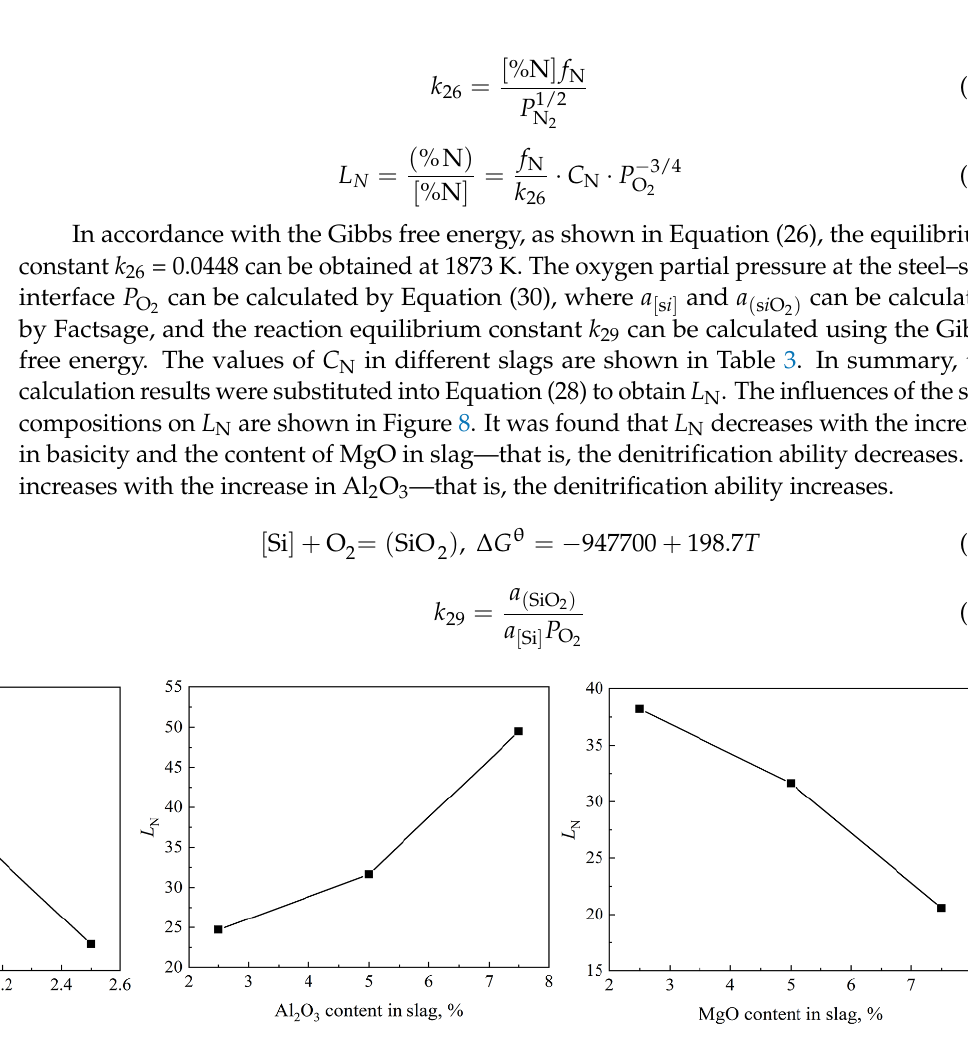
Figure 8. Equilibrium distribution ratio of